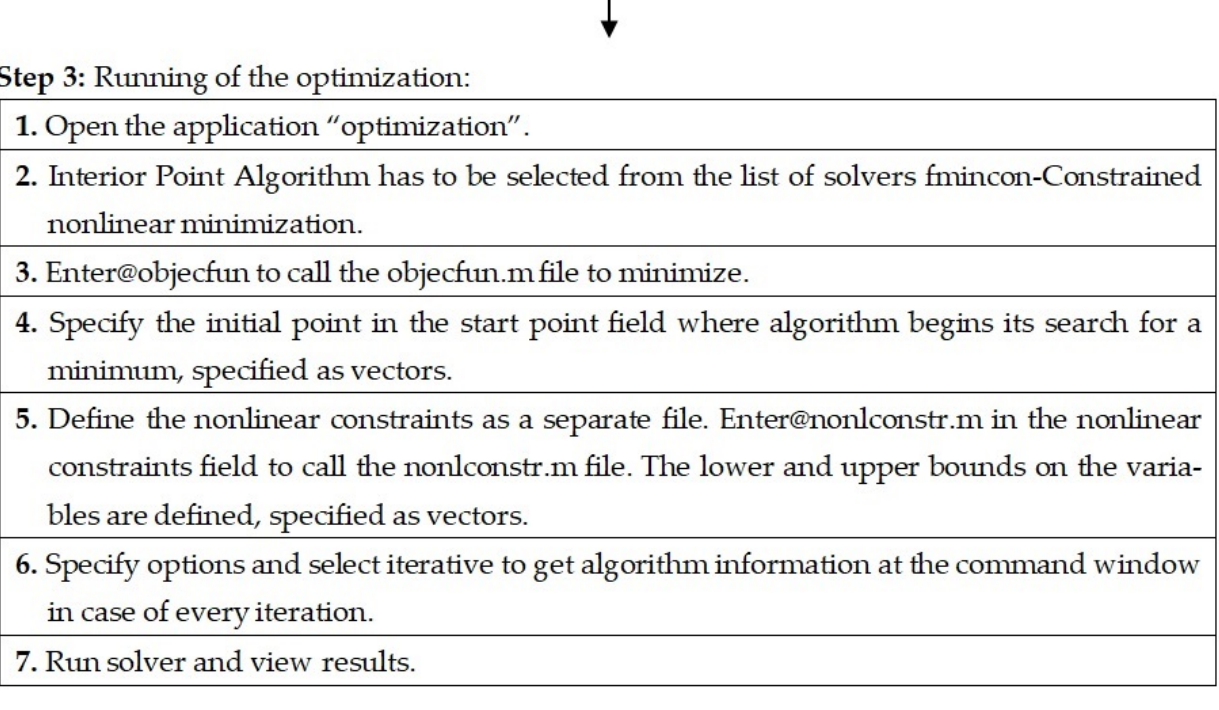
Figure 5. Flowchart for optimization procedure of single-objective function.